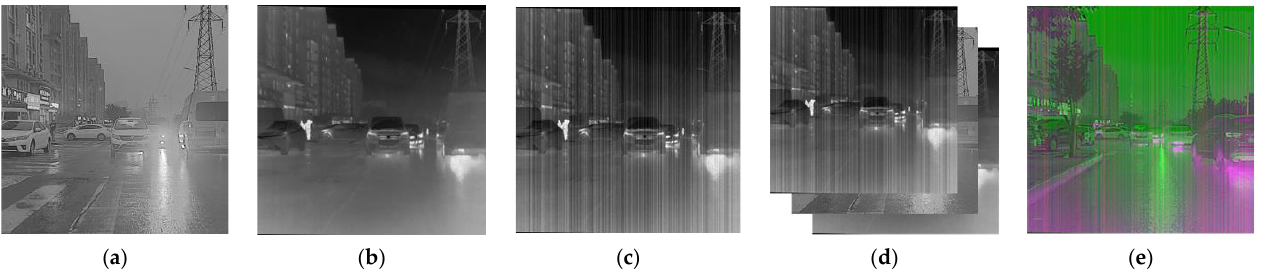
Figure 11. Dataset. ( a ) Visible gray image; ( b ) infrared image; ( c ) infrared noise image; ( d ) splicing example diagram; ( e ) image data set.